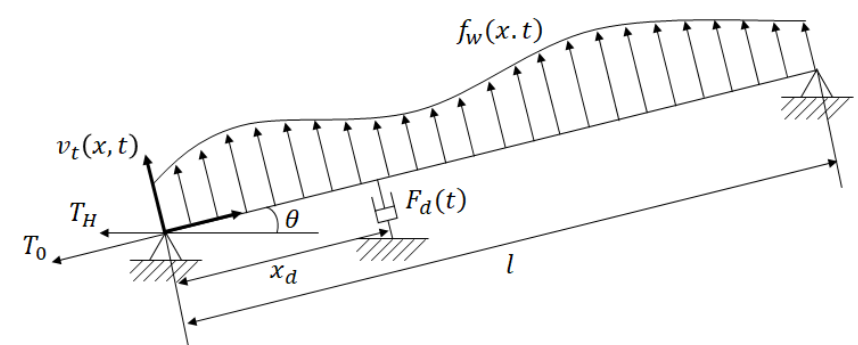
Figure 8. Cable and damper system.